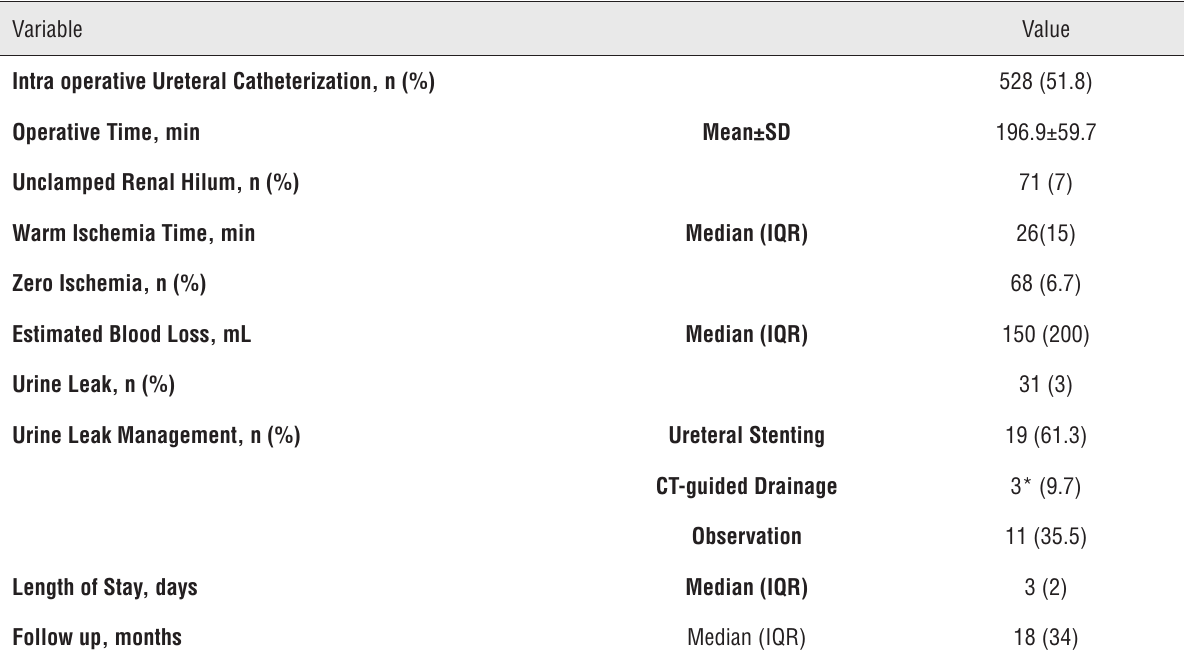
Table 2 - Surgical Outcomes